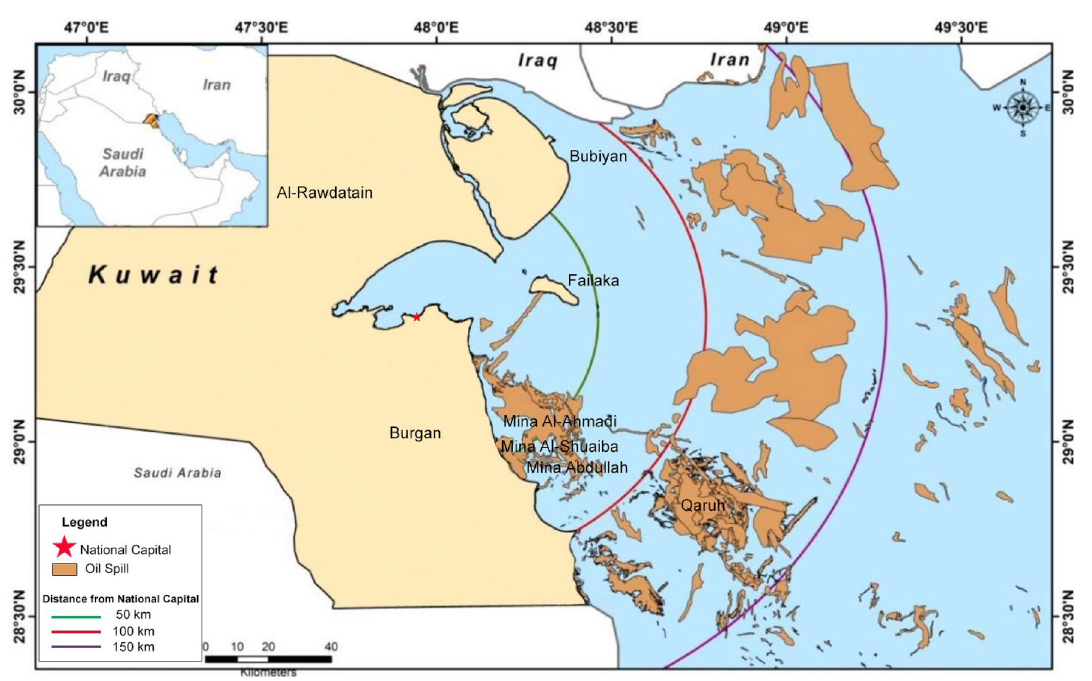
Fig. 12 Offshore oil spill hazard map for Kuwait based on 2010, 2017, and 2018 data. Source Kuwait Institute for Scientific Research